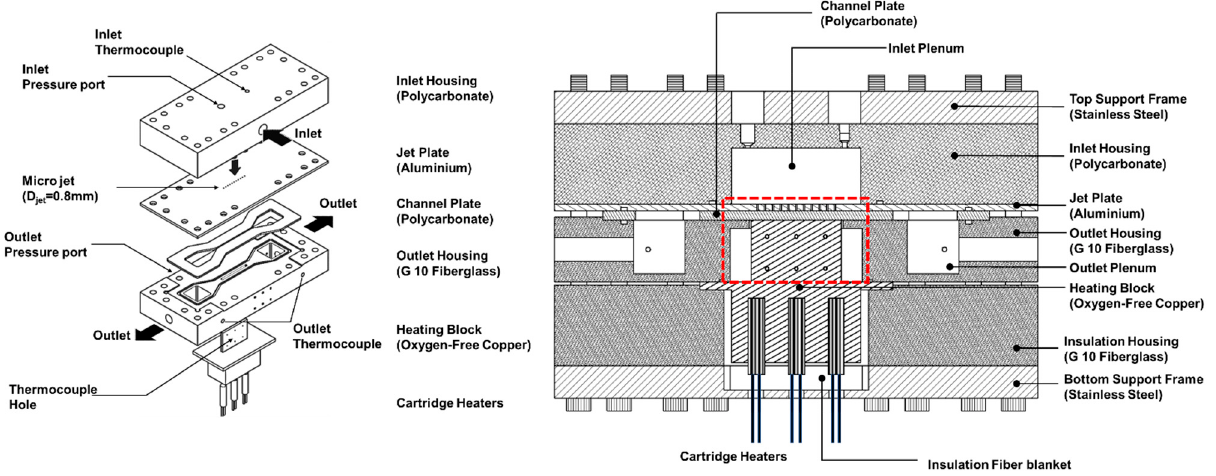
Figure 2. Exploded and sectional views of test module.